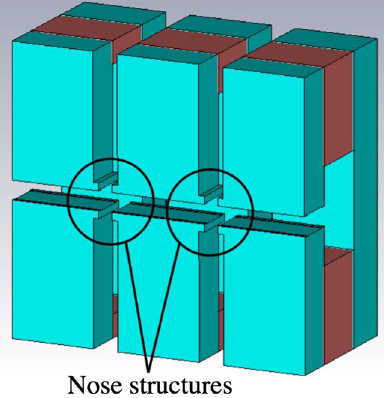
FIG. 6. Test longitudinal gradient bend (LGB) with nose